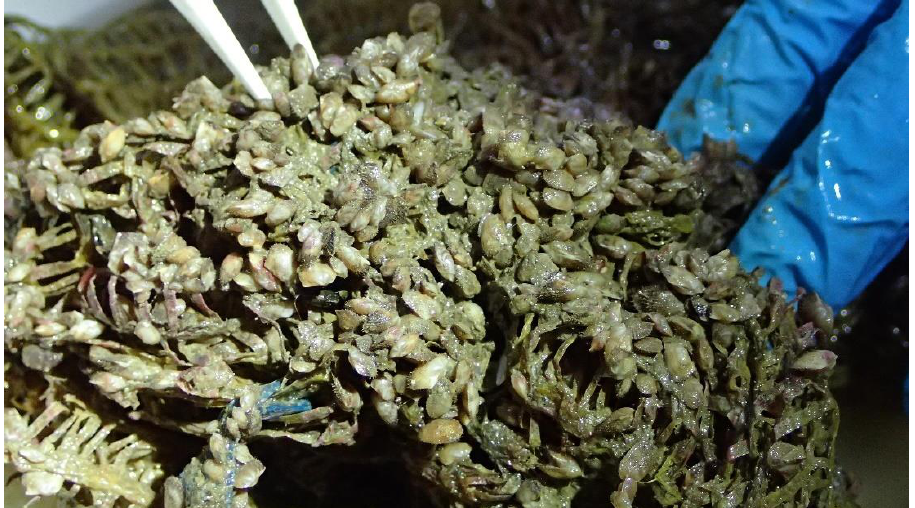
Figure 7. A collector bag from Javorike Cove that was placed at a shallow depth almost completely covered by invasive bivalve Anadara transversa (photo Tatjana